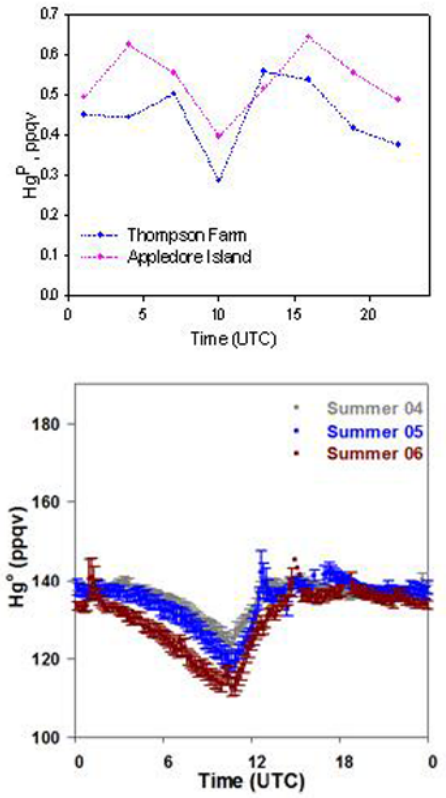
Fig. 12. Top Panel: diurnal cycle of Hg P at Thompson Farm (blue) and Appledore Island (pink) Bottom Panel: Hg 0 diurnal cycle at Thompson Farm (Mao et al., 2008) (Note: noon local time is 16:00UTC). Both sites show a minimum at night and maximum points just before and just after the minimum possibly due to night- time chemical reactions and photochemical